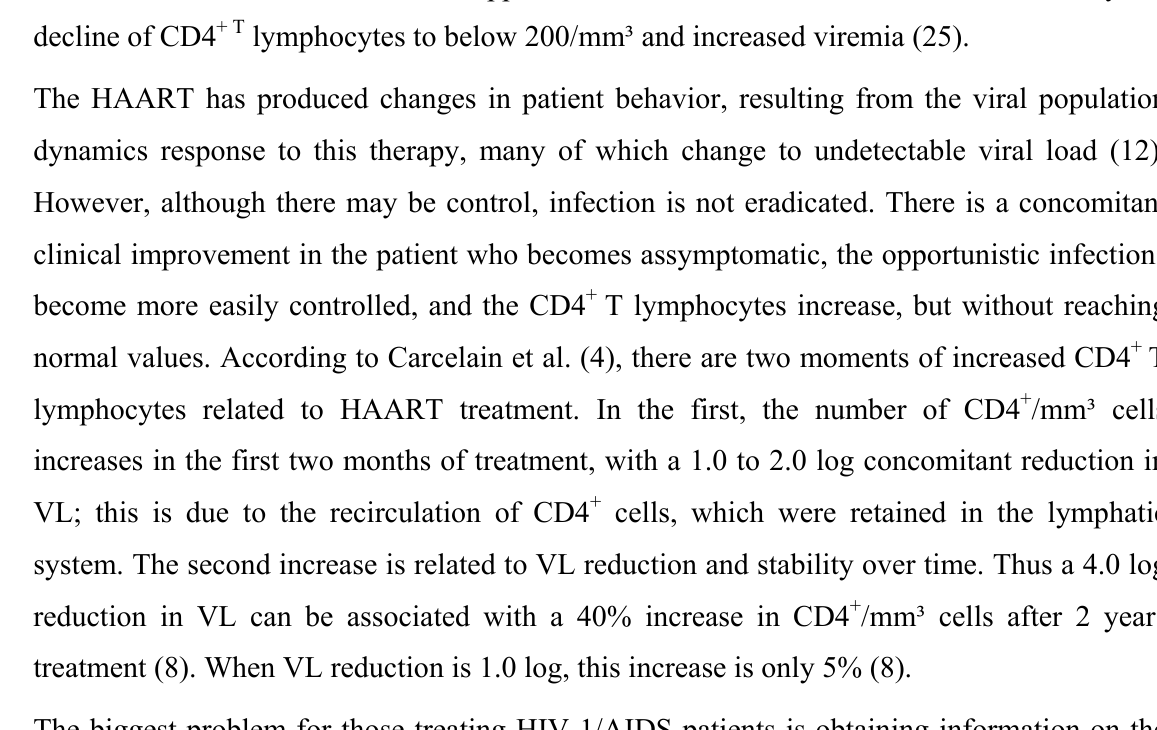
D. A. Meira et al . CORRELATION BETWEEN CYTOKINE SERUM LEVELS, NUMBER OF CD4 + T CELLS/mm³ AND VIRAL LOAD IN HIV-1 INFECTED INDIVIDUALS WITH OR WITHOUT ANTIRETROVIRAL THERAPY.